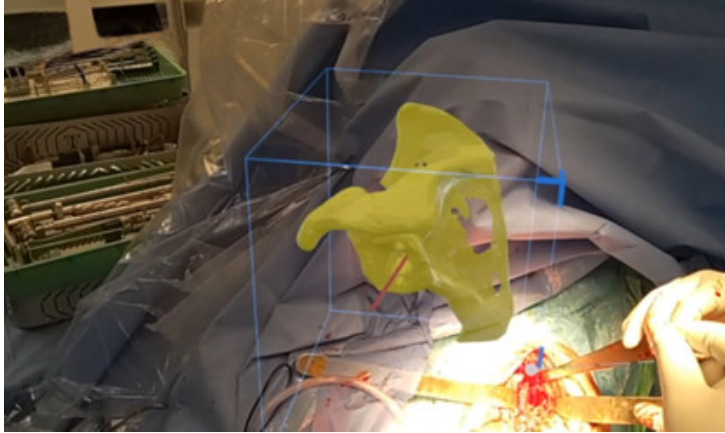
Figure 9. Intraoperative use of a hologram for surgical execution.